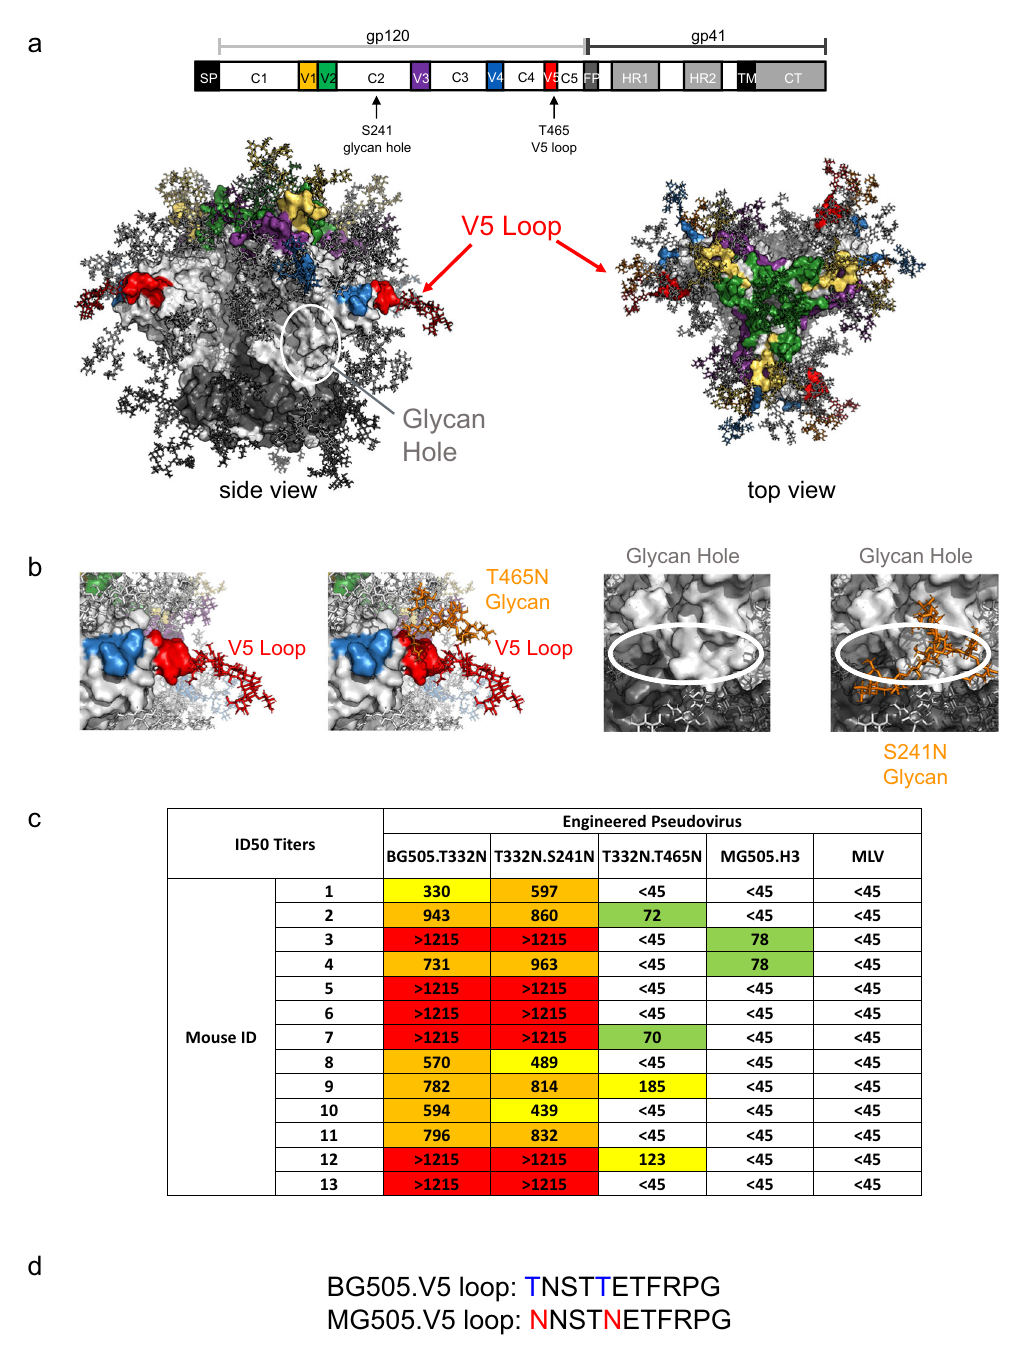
Fig. 4 Screening with engineered BG505.T332N pseudoviruses with modi fi ed glycosylation sites mapped induced murine NAb to the V5 loop of Envelope. Mice in this panel were immunized with variations of DNA-encoded BG505.MD39 at Wks 0, 3, and 16 with 25ug DNA used at each vaccination and identi fi ed to possess potent BG505.T332N neutralizing activities 2 weeks post the fi nal vaccination. a , b Rosetta modeling to demonstrate the locations of the engineered glycosylation sites ( a ) and the V5 loop ( b ) on the NLT. c Neutralization ID50 titers of heat-inactivated mice sera against listed pseudovirus isolates. d Sequence alignment of the V5 loops for BG505.W6M.ENV.C2 and